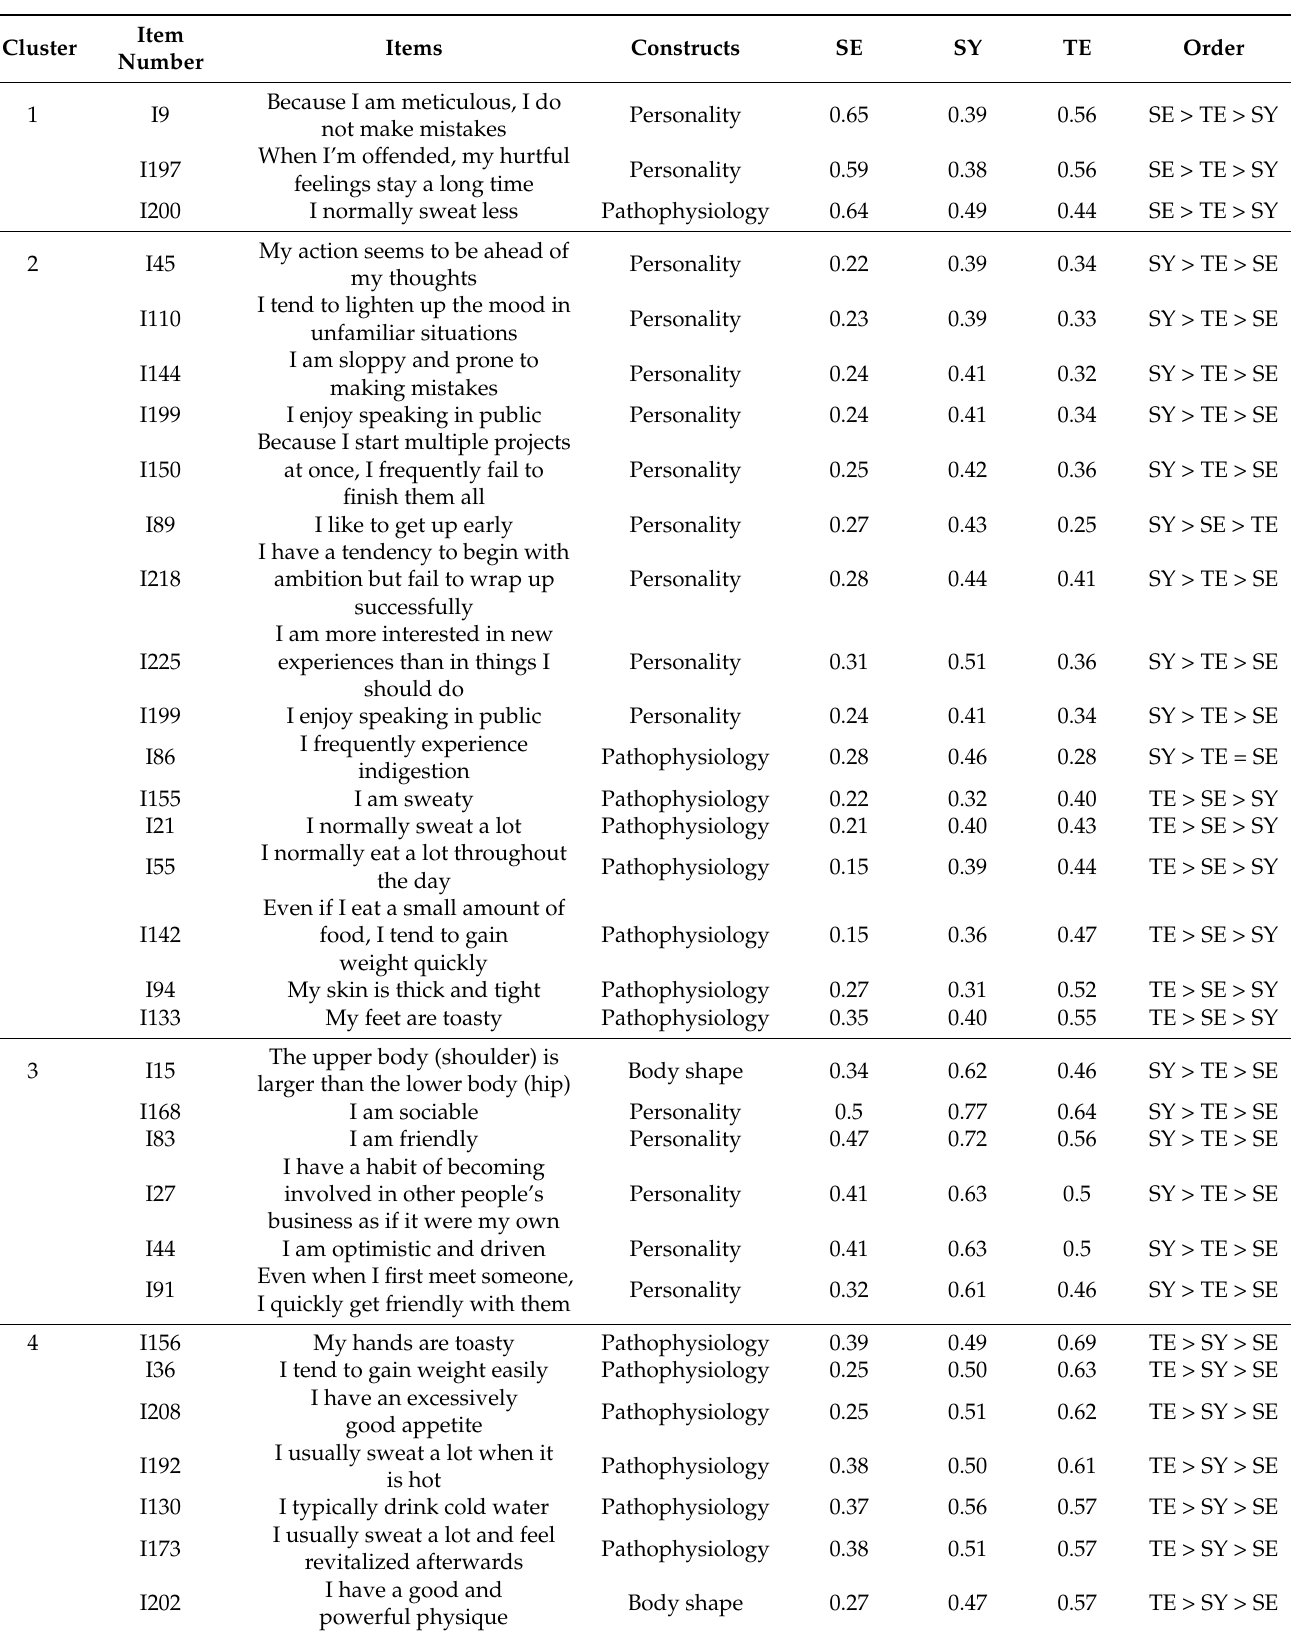
Table 1. Summary of hierarchical